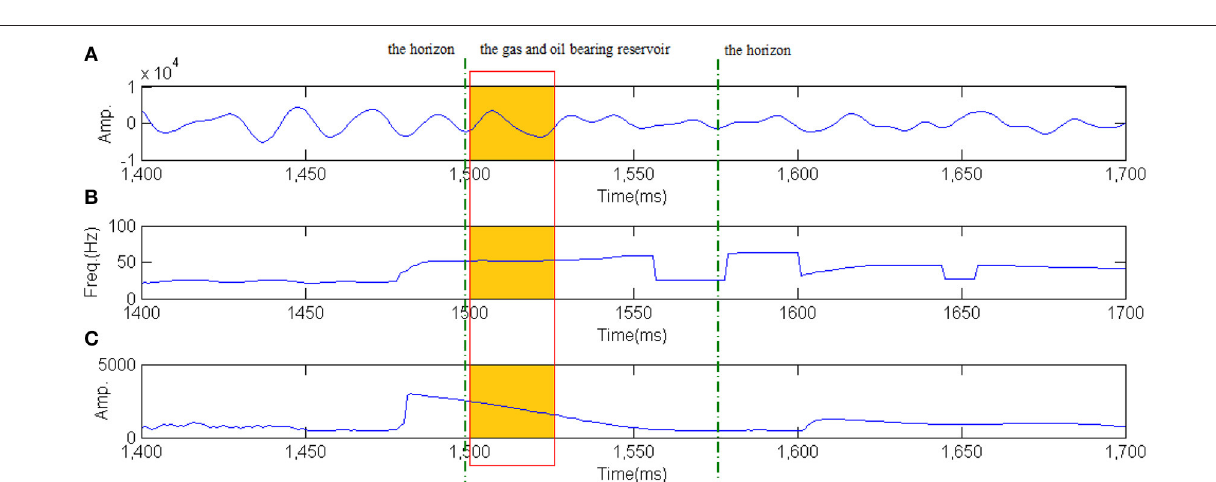
FIGURE 9 | The peak frequency and the maximum amplitude at each time sample above the average amplitude extraction using the EMD-based wavelet ridge. (A) The seismic signal at CDP stacked trace 15454 intersecting well A. (B) The peak frequency with maximum energy at each time sample. (C) The maximum amplitude at each time sample above the average